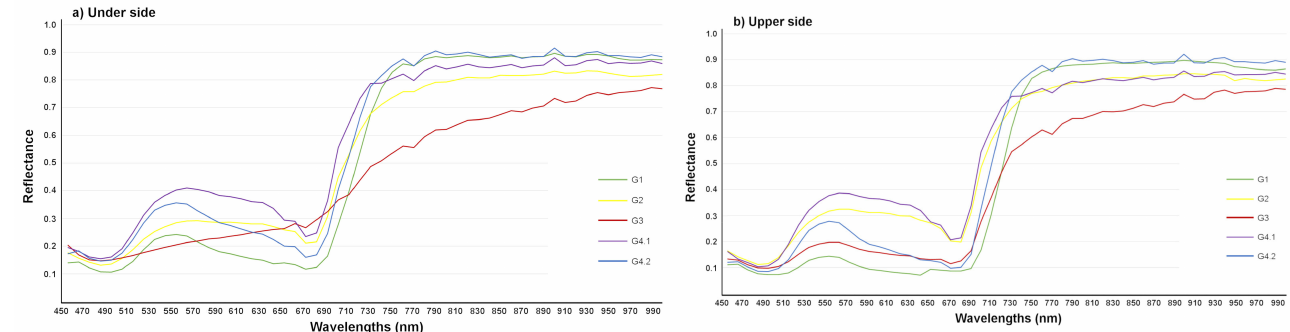
Figure 8. Mean spectra of healthy leaves (G1), damage by T. urticae (G2) and P. citrella (G3), and leaves with N deficiency (G4.1) and with other deficiencies (G4.2) on ( a ) under and ( b ) upper side.